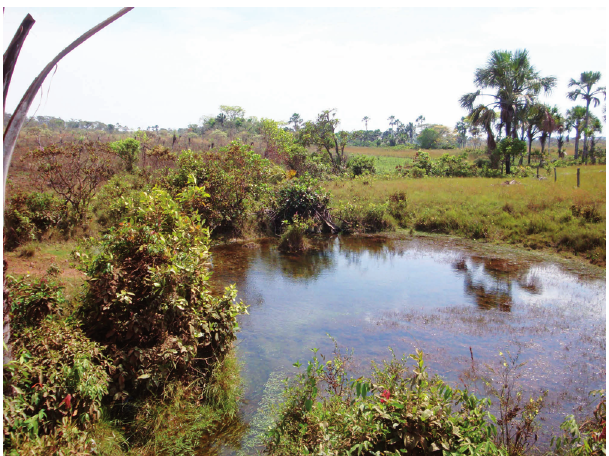
Fig. 3. Type locality of Hasemania kalunga . Brazil, Goiás State, Cavalcante, córrego in the road GO 241 between Cavalcante and Minaçu, tributary of rio das Almas, rio Paranã drainage, upper rio Tocantins basin.